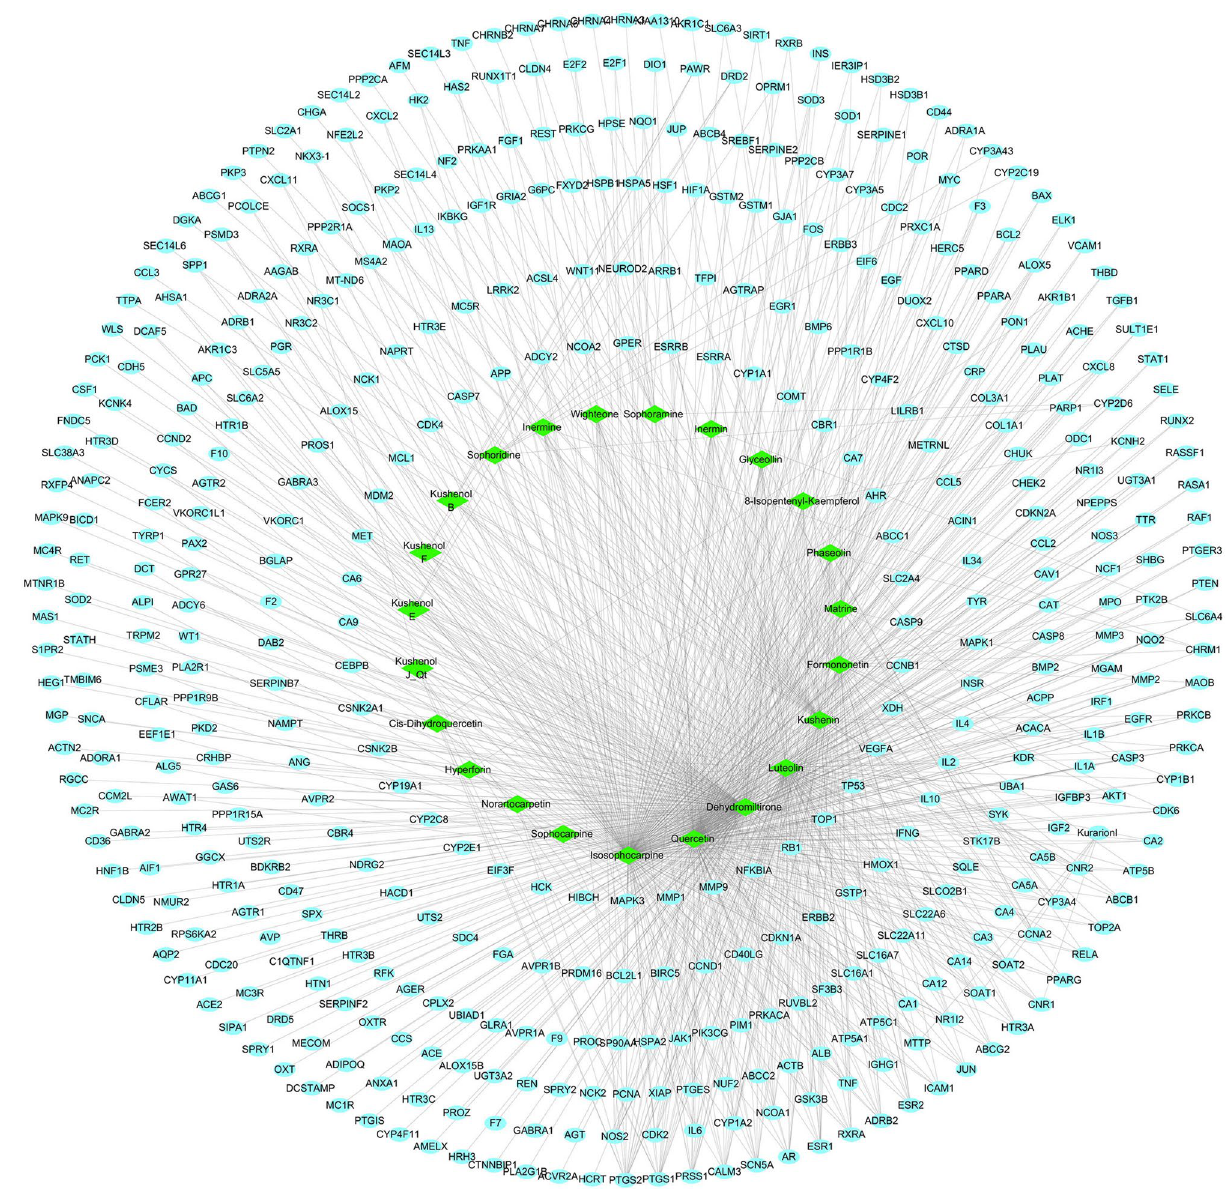
Figure 2. The Compound-Target network of Kushen. Green nodes indicate bioactive compounds, blue nodes indicate target proteins, and edges indicates interaction between ingredients and targets.